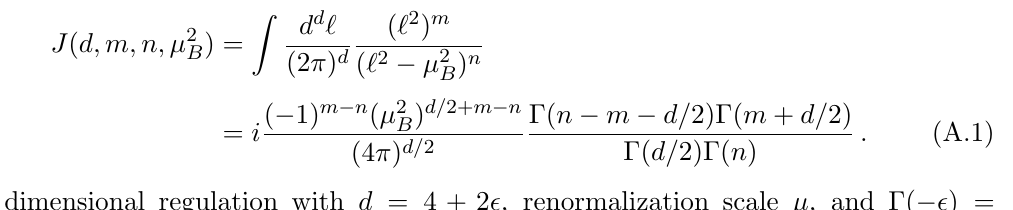
Figure 11 . Self-energy diagram for the d ! s transition mediated by color-triplet diquark H 3 . diagrams, we show the useful d -dimensional integral